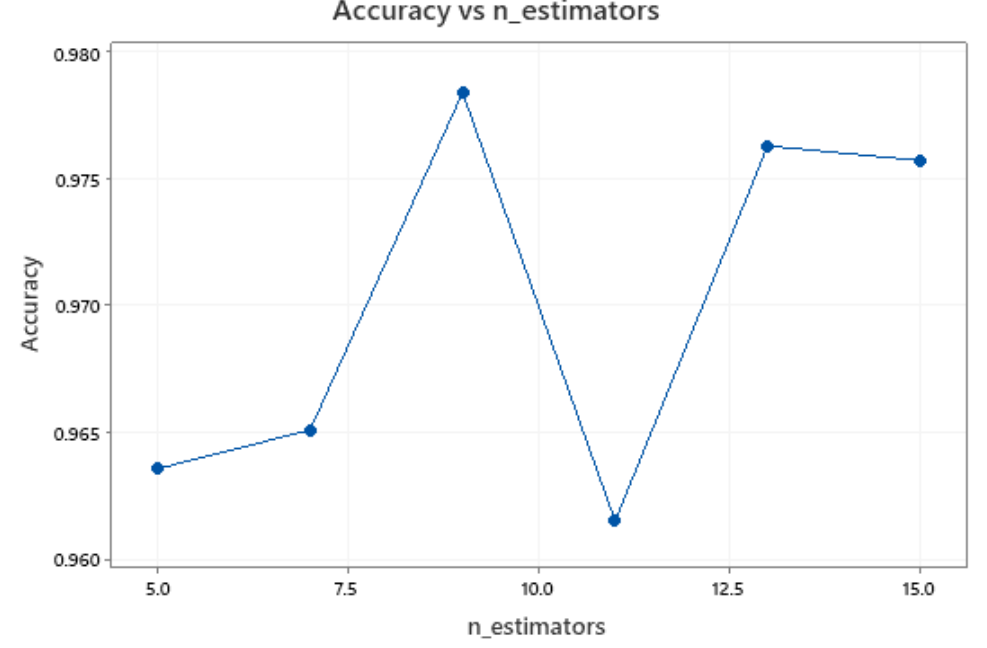
Figure 10. Impact on random forest accuracy for increasing numbers of